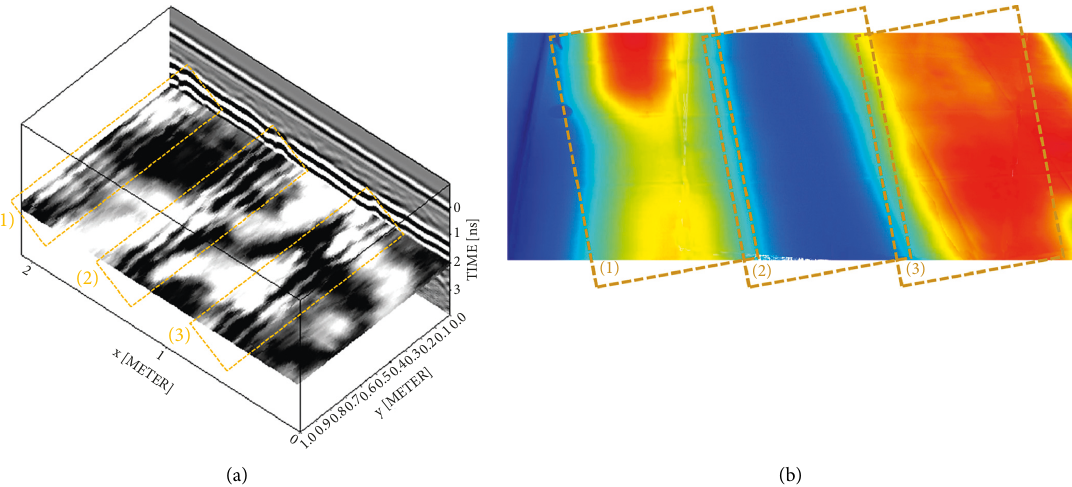
Figure 8: GPR results (a) showing the existence of three pipes, while IRTresults (b) show the functioning of only two pipes. The conjoint study allows detecting the failure in performance of one of the pipes in the radiant heating system (modified from [55]).